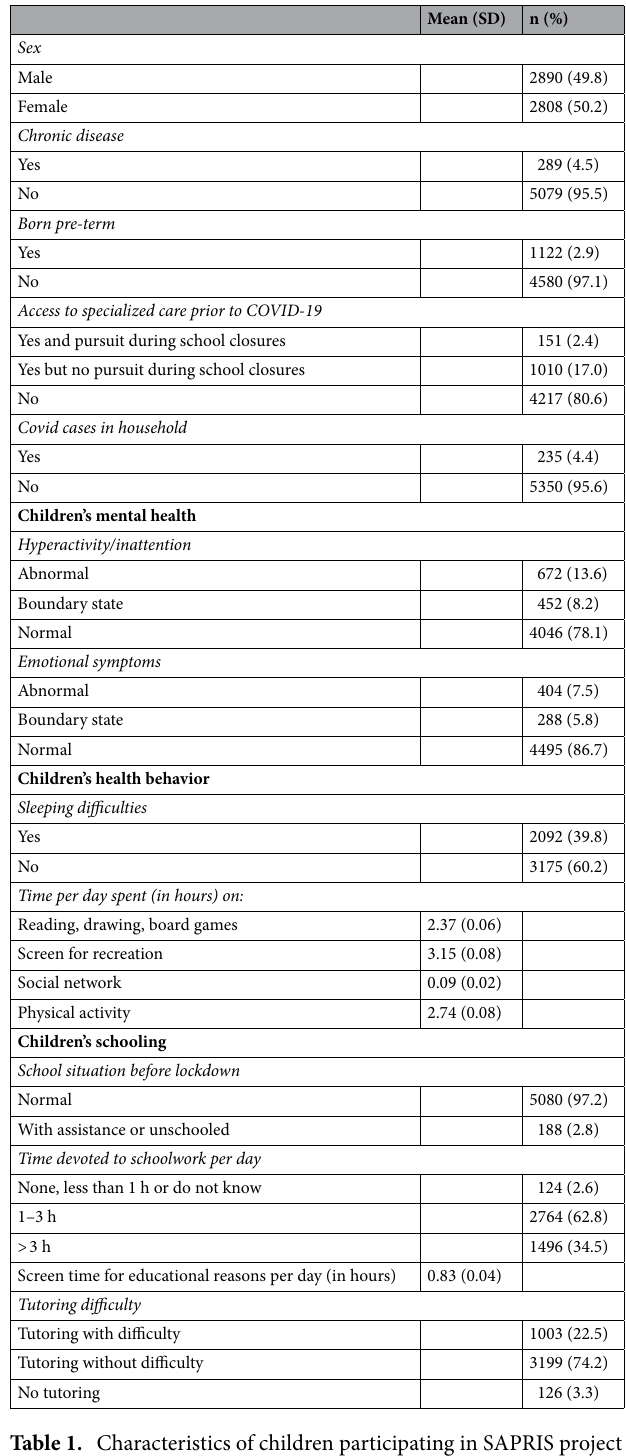
Table 1. Characteristics of children participating in SAPRIS project in France on weighted data (n =